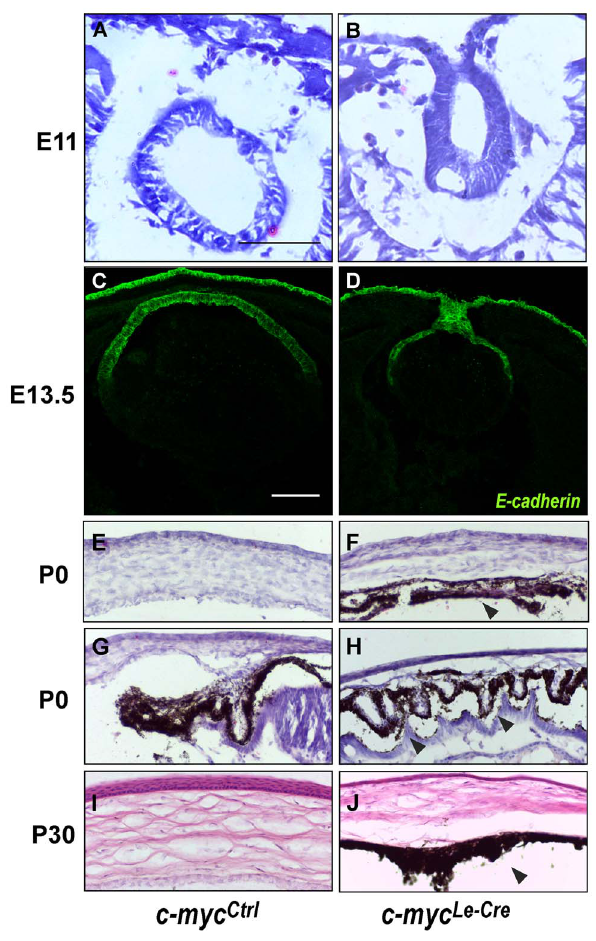
Figure 3. Loss of c-myc leads to development defects in the anterior chamber. Representative pictures of hematoxylin & eosin (H&E) staining at E11.0 (A, B) and immunofluorescence for E-cadherin at E13.5 (C, D) illustrates the defective lens vesicle formation, which leads to the formation of the lens stalk. (E–J) H&E staining of anterior segment at P0 (E–H) and P30 (I–J) demonstrates that c-myc Le-Cre eyes presented corneal stroma loosening, absence of corneal endothelium and presence of pigmented cells along the anterior chamber (at P0 and P30, arrowheads in F, H and J). Scale bar: 100 m m.